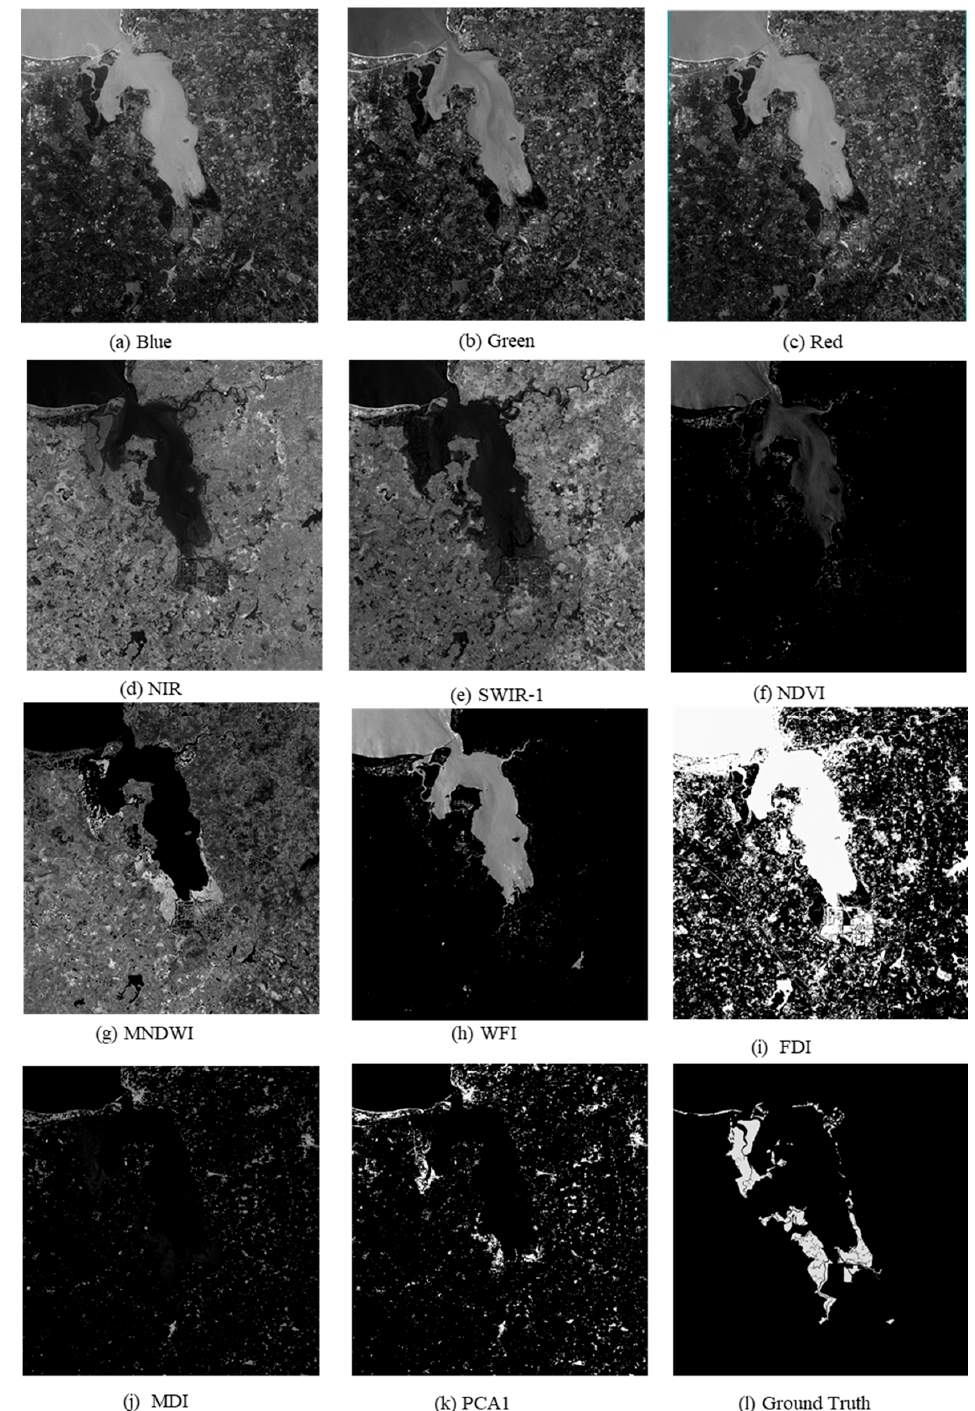
and the corresponding ground truth labels were used as inputs to the ME-Net model. The input data used by the deep neural network are shown in Figure 8.